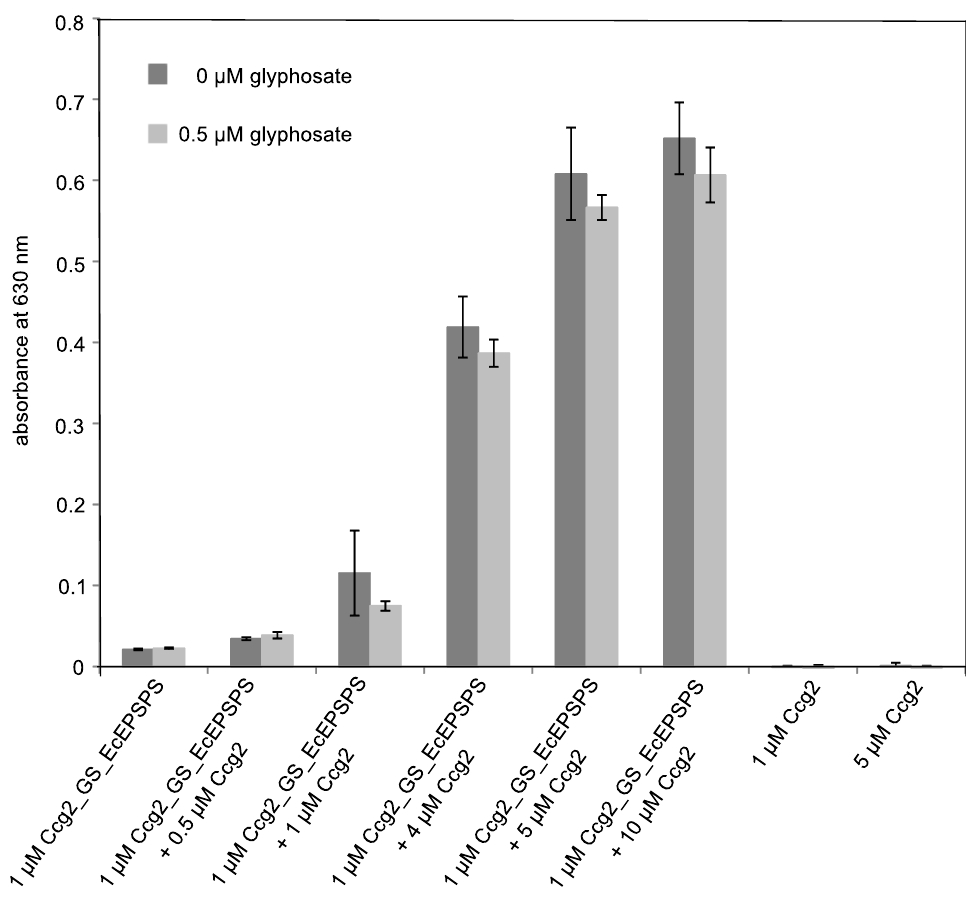
Figure 4. Activity measurements using the malachite green assay with polystyrene surfaces functionalized with Ccg2_GS_EcEPSPS and Ccg2 in di ff erent ratios (triplicate measurement). Absorbance at a wavelength of 630 nm was determined using